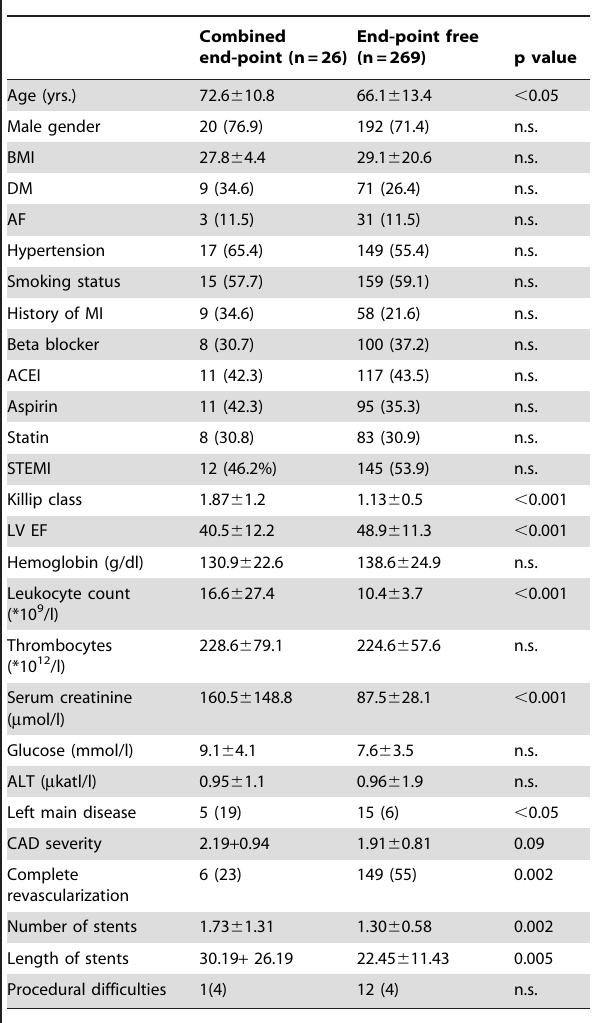
vs.10.4 6 3.7, p , 0.001. The correlation between markers of apoptosis and